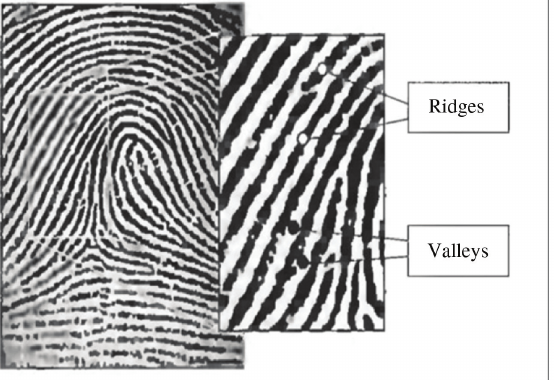
Figure 1: Ridges and Valleys in a